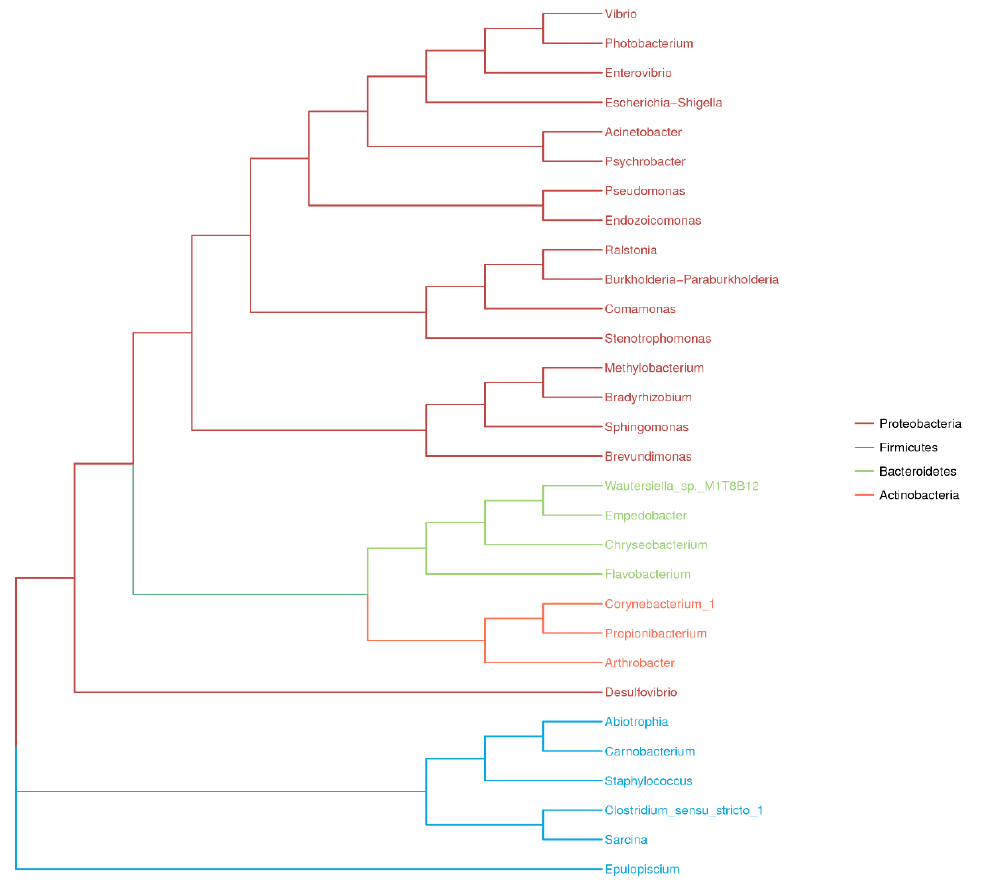
Figure 5. Phylogenic tree of the top 30 most abundant microbial OTUs recovered in the four fish species from the South China Sea revealed by high-throughput Illumina sequencing 3.4. Core and Unique Gut Microbial Community in Four Coral Reef Fishes from the South China Sea